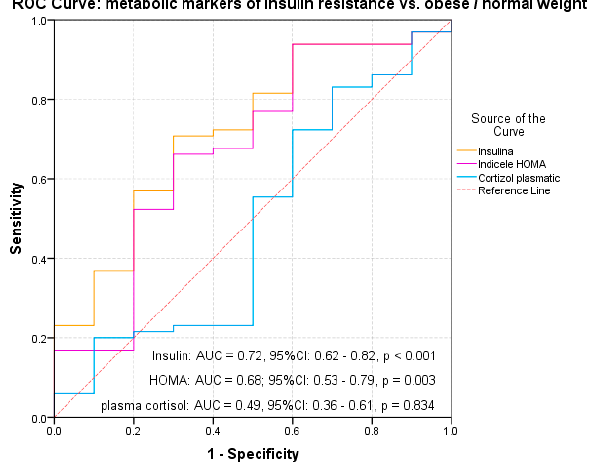
Figure 5. ROC curves for metabolic markers of insulin resistance and obesity in children and adolescents.